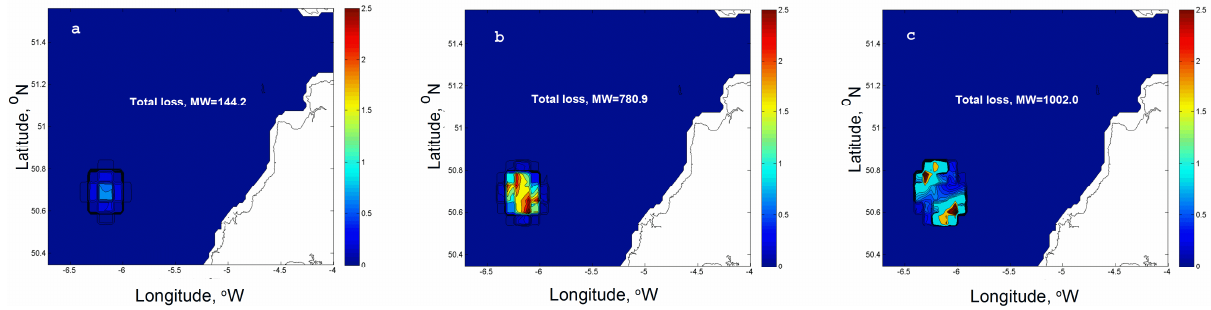
Fig. 5. Spatial distribution of the mean extracted power in Wm − 2 for the 3 versions of the tidal energy farm: (a) low, (b) medium and Fig.5. Spatial distribution of the mean extracted power in W/m 2 for the 3 versions of 649 (c) high rated power capacity. Averaging is performed over a 50-hour period during the spring tides. The total (area integrated) value of